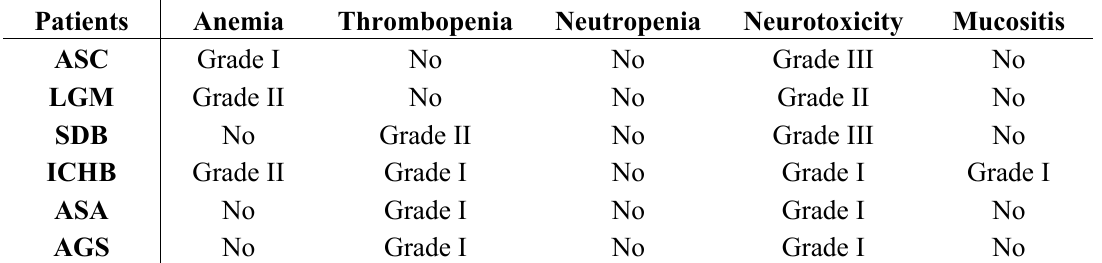
Table 1. Patients selected for this study and their grade of